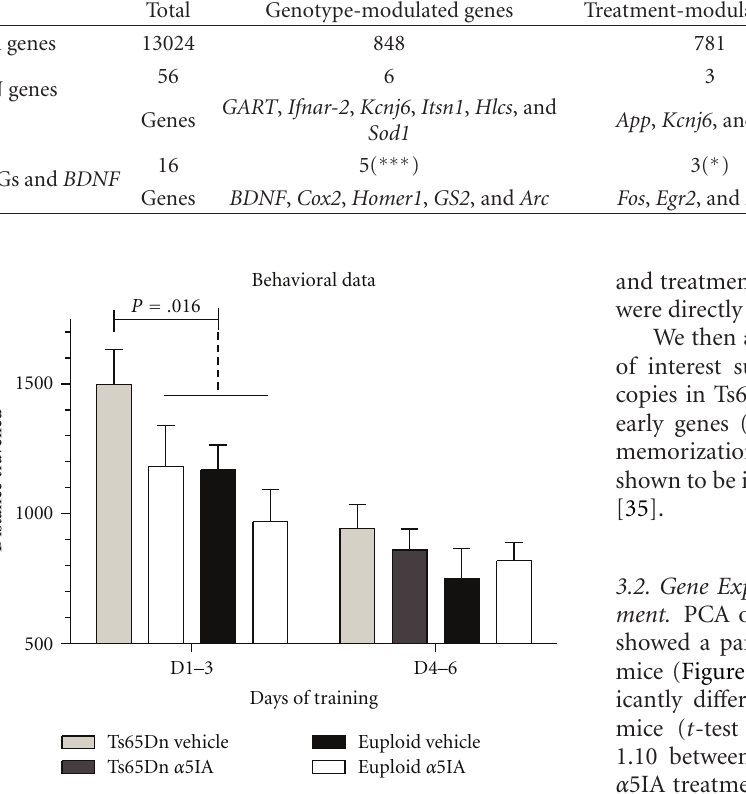
Figure 2: E ff ects of α 5IA treatment in Ts65Dn mice trained in the MWM task. TS65Dn mice had impaired performance in the MWM task (comparison with other groups: P < . 025). This deficit was rescued by treatment with α